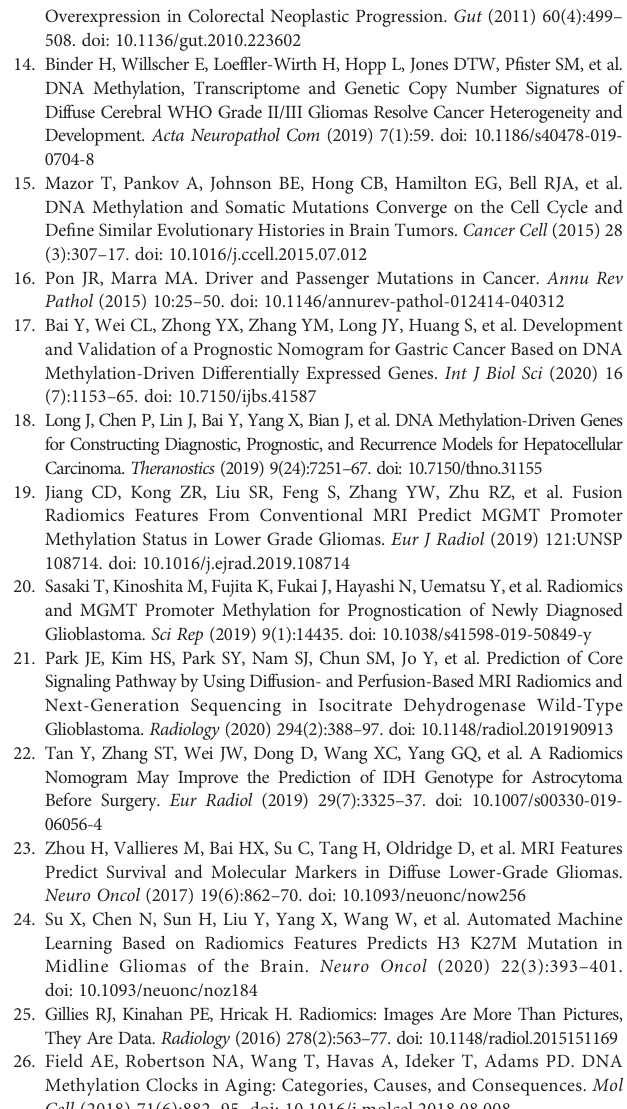
expression, EMP3 expression, MEOX2 expression, OCIAD2 expression, TGFB2 expression, TNFRSF12A expression and transcriptional risk score which classi fi ed by optimal cutoff value derived from X-tile based on CGGA database, respectively (all P <0.001, with log-rank test). (H) , the risk factor association diagram in CGGA cohort. The results showed the blue dots in the fi gure represented the surviving LGG patients while the red dots represented death, and the corresponding risk gene cluster mRNA expression pro fi les were visualized as a heatmap. The dotted line indicated that the optimal cut-off value of mRNA risk score, with which all LGG patients were divided into two groups including 65 low transcriptional risk score samples and 50 high transcriptional risk score samples. Supplementary Figure 14 | The validation of nomogram in CGGA dataset. (A-C) , the calibration curves of 1-, 3- and 5-years showed more appropriate calibration ability in CGGA cohort, which the blue dotted lines represented the ideal predictive model, and the red solid line represented the nomogram model. (D) , the time dependent ROC curves analysis for nomogram during 1-, 3- and 5-years in CGGA cohort,